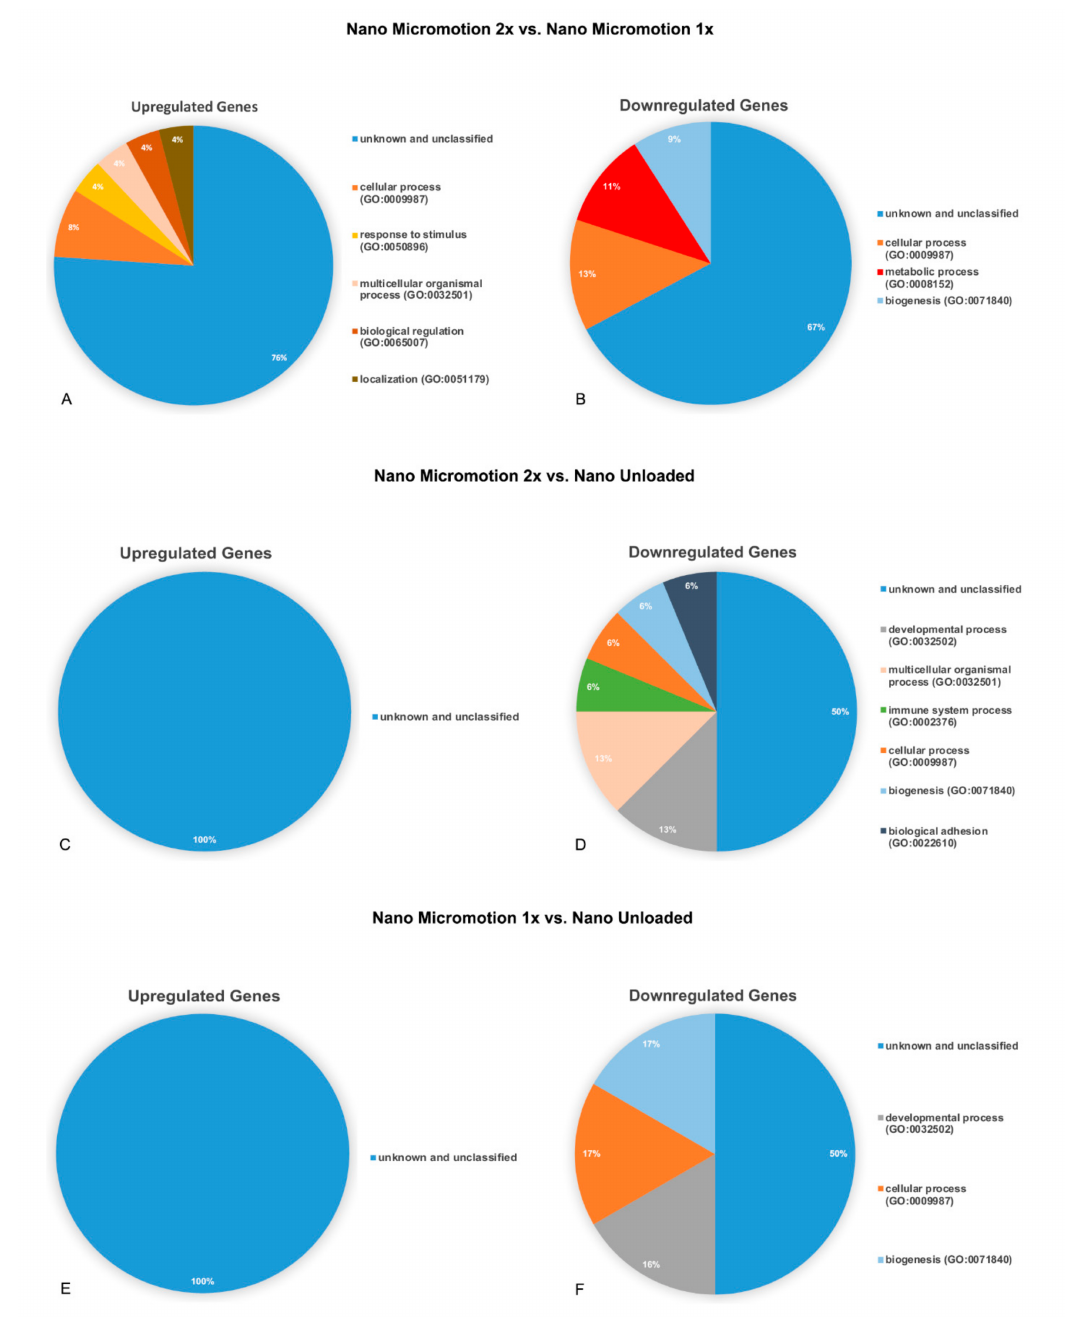
Figure 7. Pie charts showing the distribution of biological process ontologies (BP) related to upregulated ( A , C , E ) and downregulated ( B , D , F ) di ff erentially expressed genes ( p < 0.05). ( A , B ) Nano Micromotion 2x group vs. Nano Micromotion 1x group; ( C , D ) Nano Micromotion 2x group vs. Nano Unloaded group, and ( E , F ) Nano Micromotion 1x group vs. Nano Unloaded group at day 7